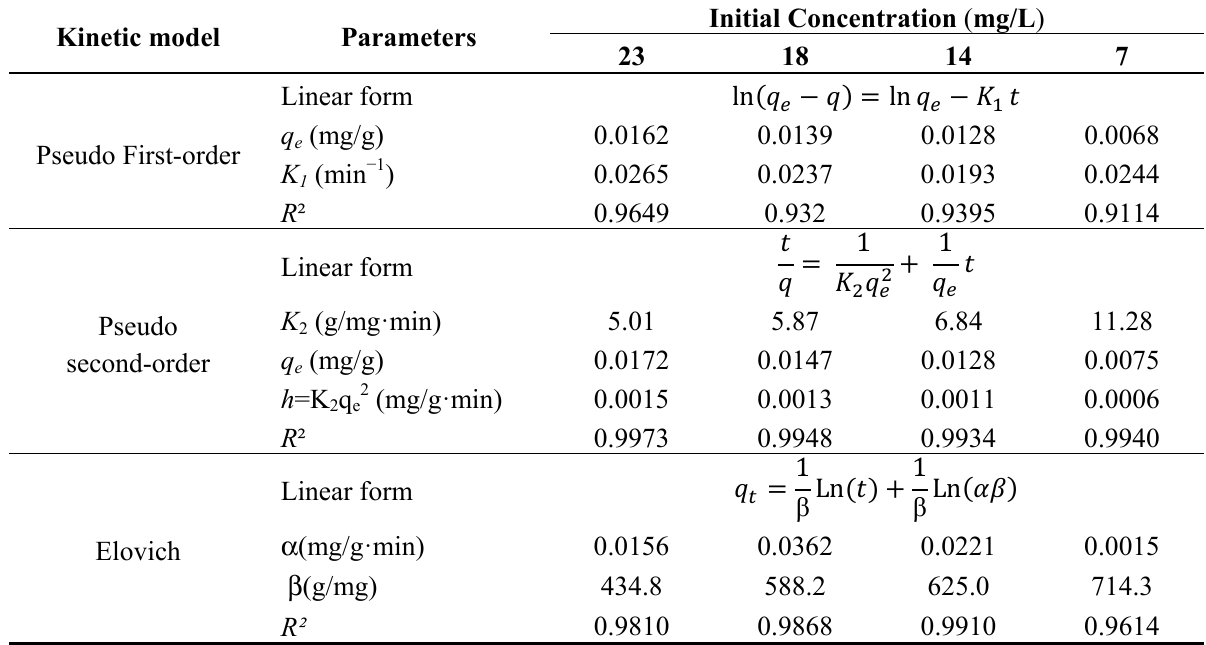
Table 3. Kinetic parameters for different initial Cu 2+ concentrations ( γ Mn/g sand, pH = 5, T = 25.6